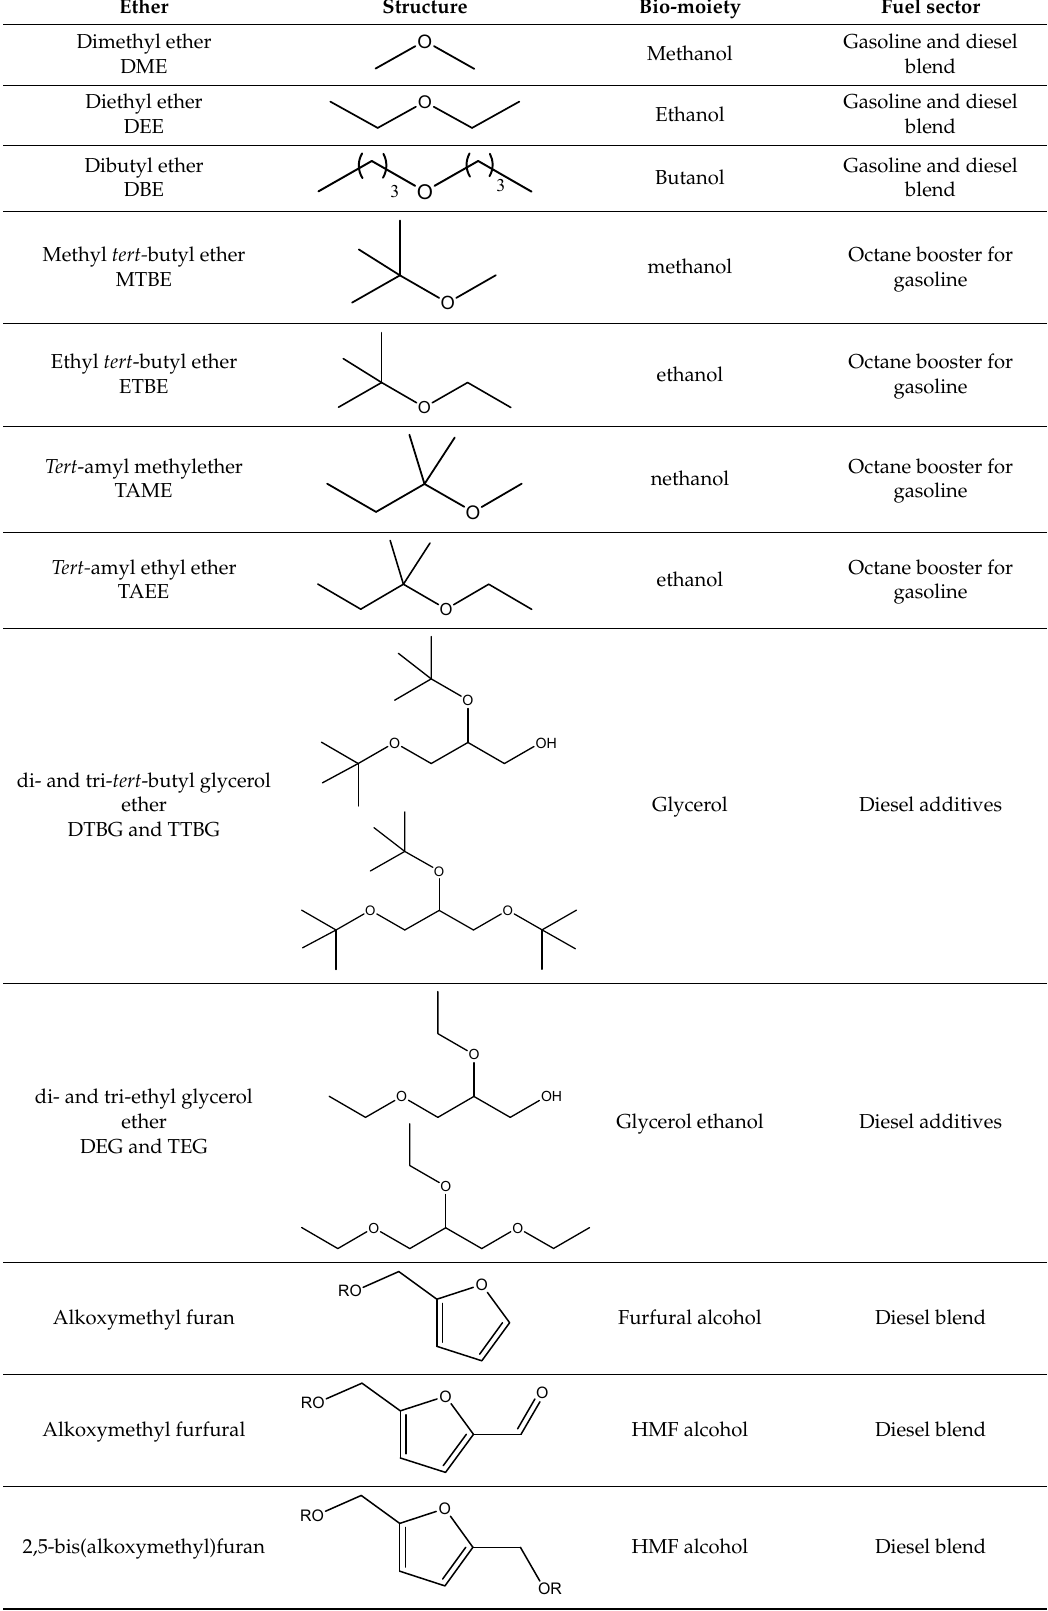
Table 1. Most widespread ethers for fuel applications. Table 1 . Most widespread ethers for fuel applications Table 1 . Most widespread ethers for fuel applications Table 1 . Most widespread ethers for fuel applications Table 1 . Most widespread ethers for fuel applications Table 1 . Most widespread ethers for fuel applications Table 1 . Most widespread ethers for fuel applications Table 1 . Most widespread ethers for fuel applications Table 1 . Most widespread ethers for fuel applications Table 1 . Most widespread ethers for fuel applications Table 1 . Most widespread ethers for fuel